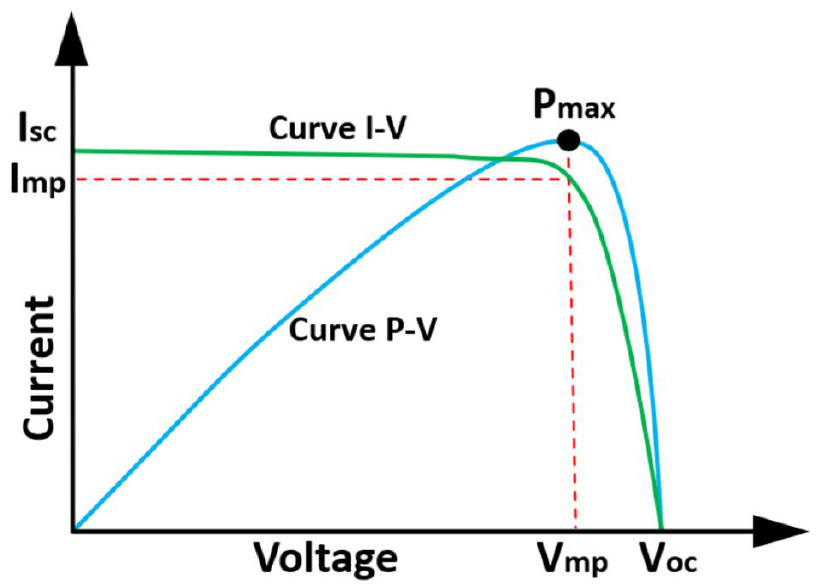
Figure 2. I-V and P-V curves of a SPV panel (adapted with permission from Ref. [108] Copyright 2015, Kumar, P., et al.).